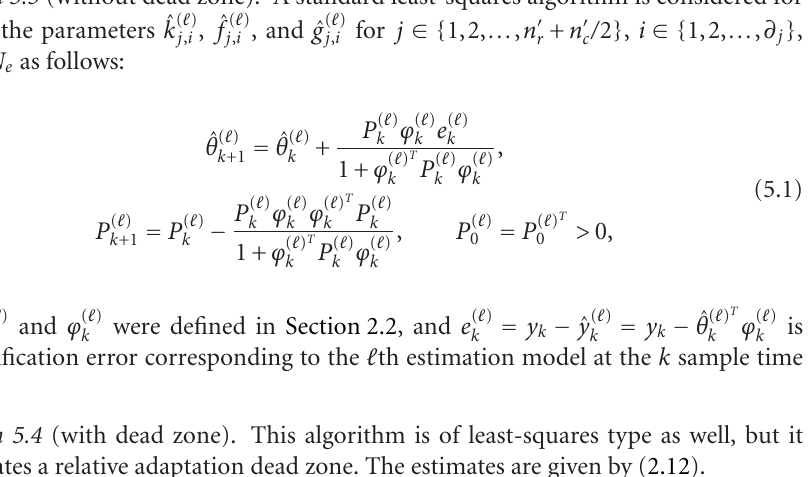
Algorithm 5.3 (without dead zone). A standard least-squares algorithm is considered